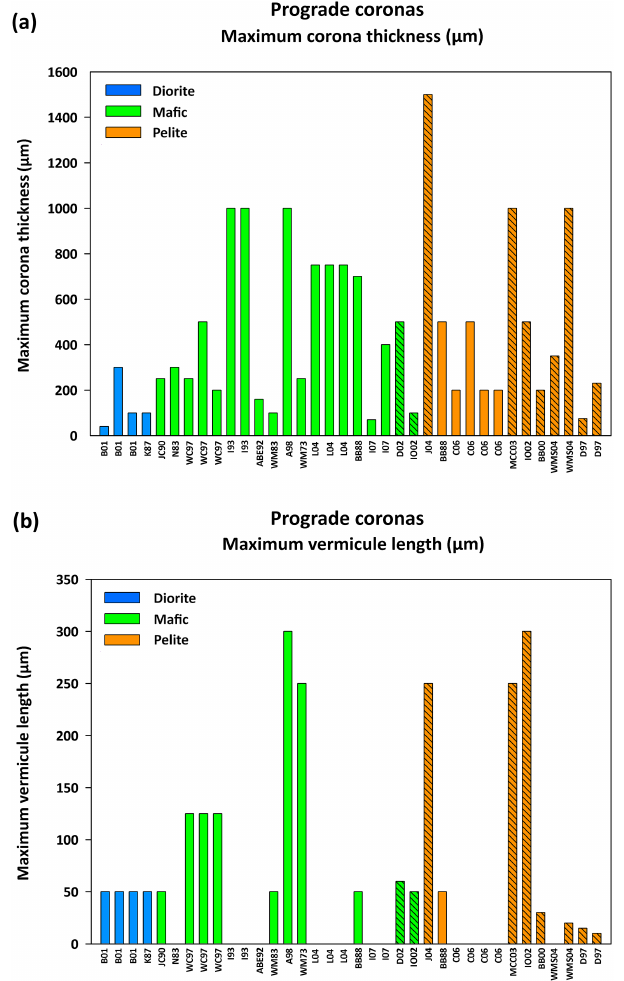
Figure 11. Variation in retrograde corona microstructure in mafic and pelitic bulk rock compositions. (a) Variation in maximum corona thickness in retrograde coronas. (b) Variation in maximum vermicule length in retrograde